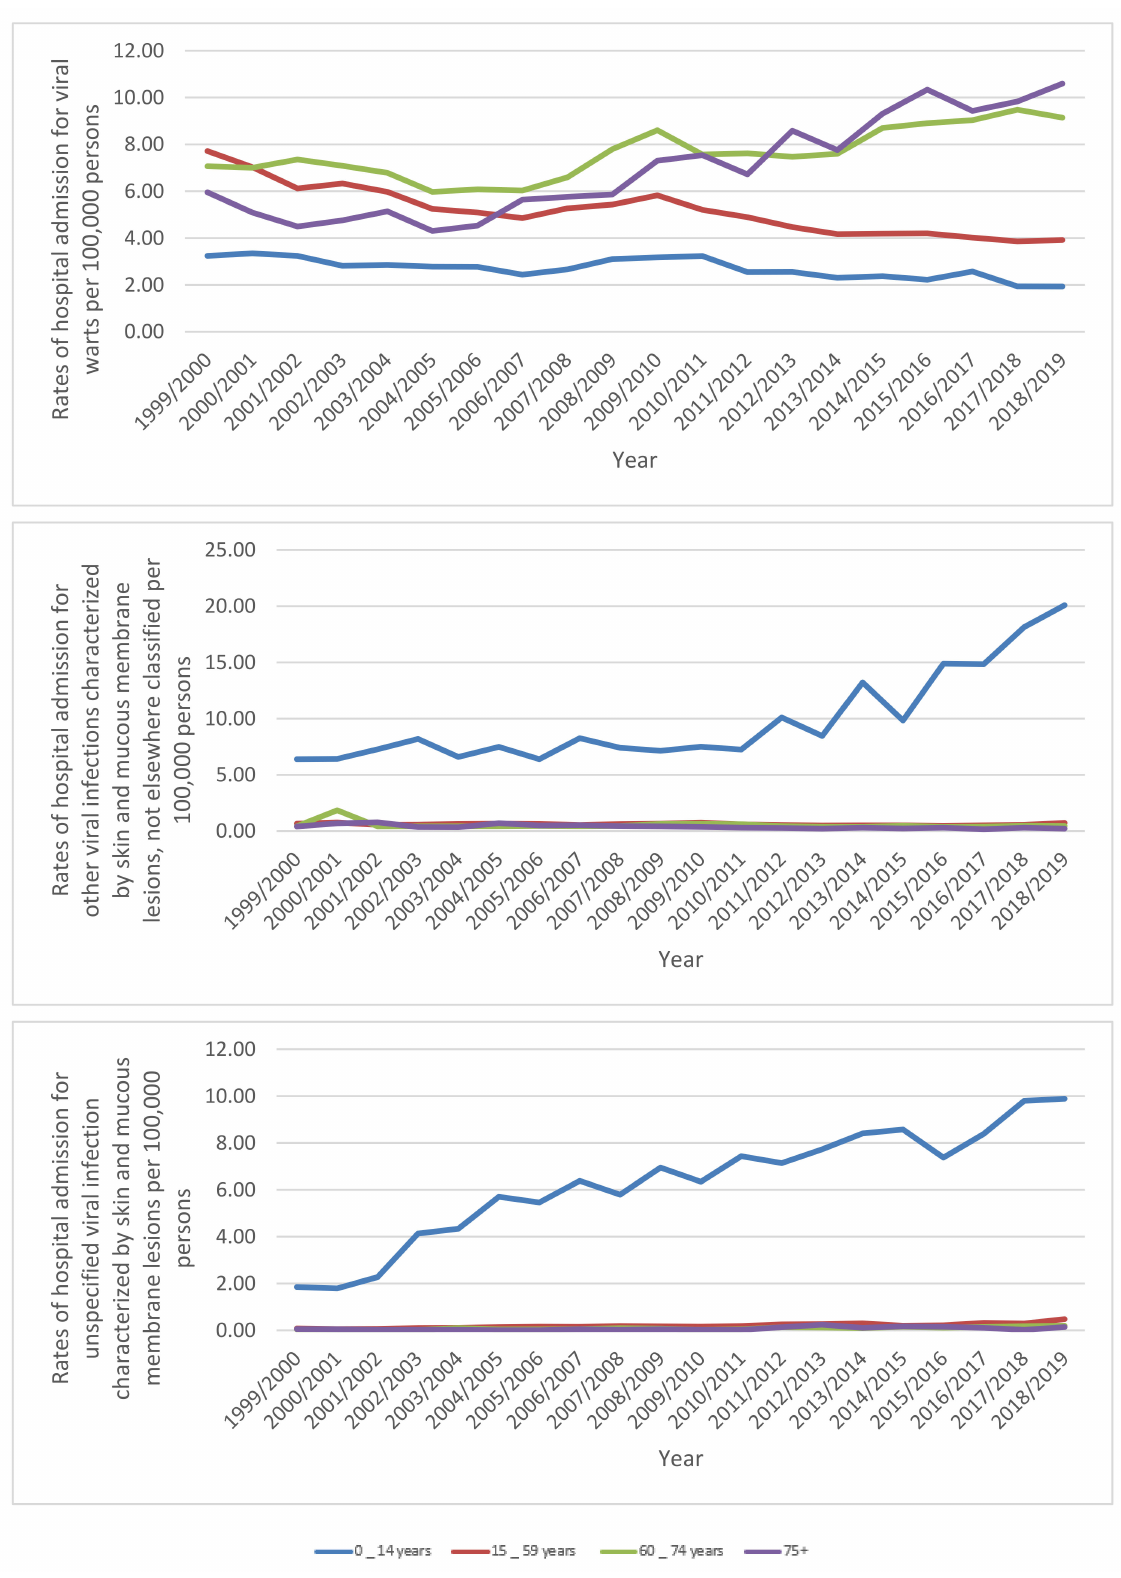
Figure 5. Hospital admission rates in England and Wales stratified by age group. Brisson and Edmunds found that the average incidence rates for zoster and varicella between 1991 and 2000 were 373 and 1291 per 100,000 inhabitants, and the overall